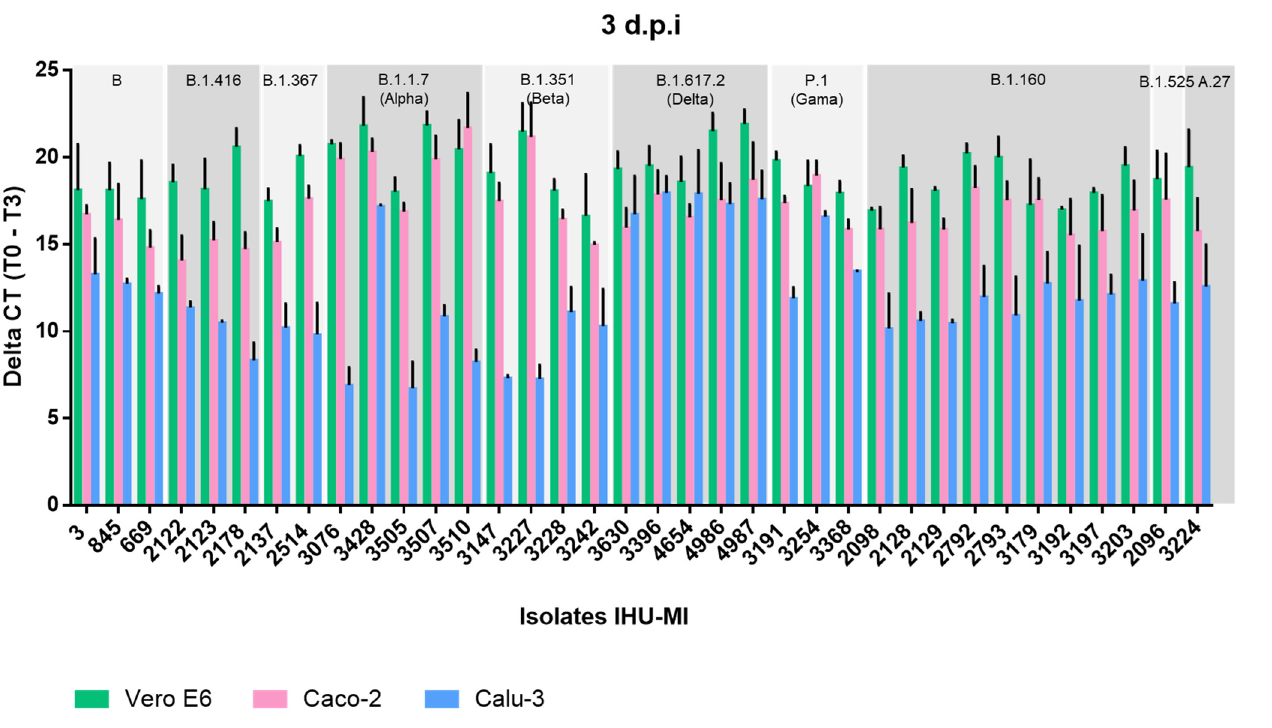
Figure 1. Replication rate of different SARS-CoV-2 lineages isolated in distinct cell lines. The replication rate of 36 SARS-CoV-2 isolates is expressed in delta CT (cycle threshold), three days post-infection, in cells derived from monkey kidney epithelium (Vero E6 in green), human intestines (Caco-2 in pink) and human lungs (Calu-3 in blue). Each isolate was classified according to its lineage, based on the PANGO classification, and viruses from the same lineage were grouped